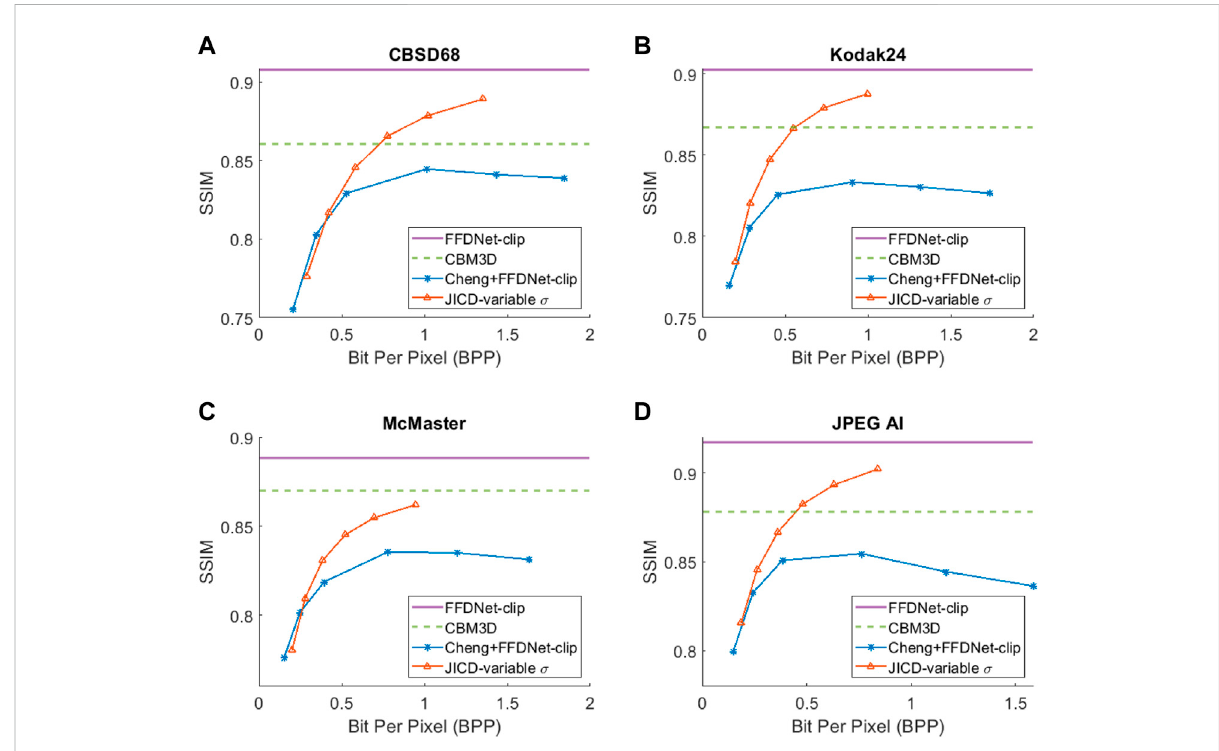
FIGURE 10 Denoising rate-SSIM curves for the unseen noise: (A) CBSD68, (B) Kodak24, (C) McMaster, (D) JPEG